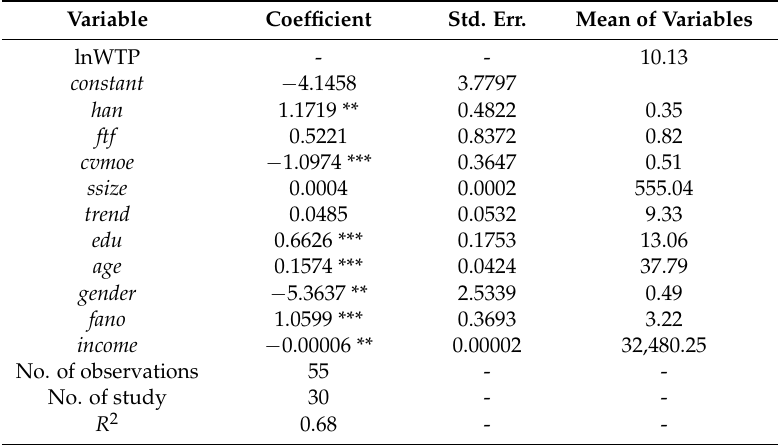
Table 3. Optimized random effects meta-regression